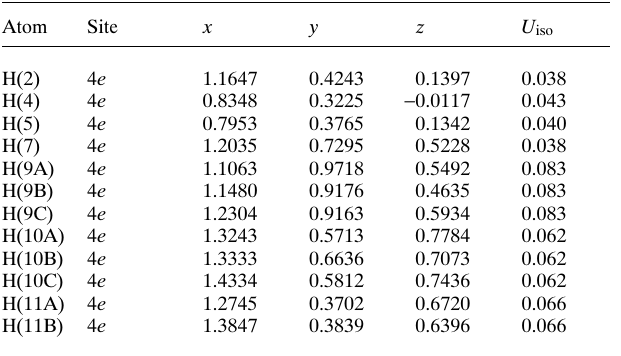
Table 2. Atomic coordinates and displacement parameters (in Å 2 )